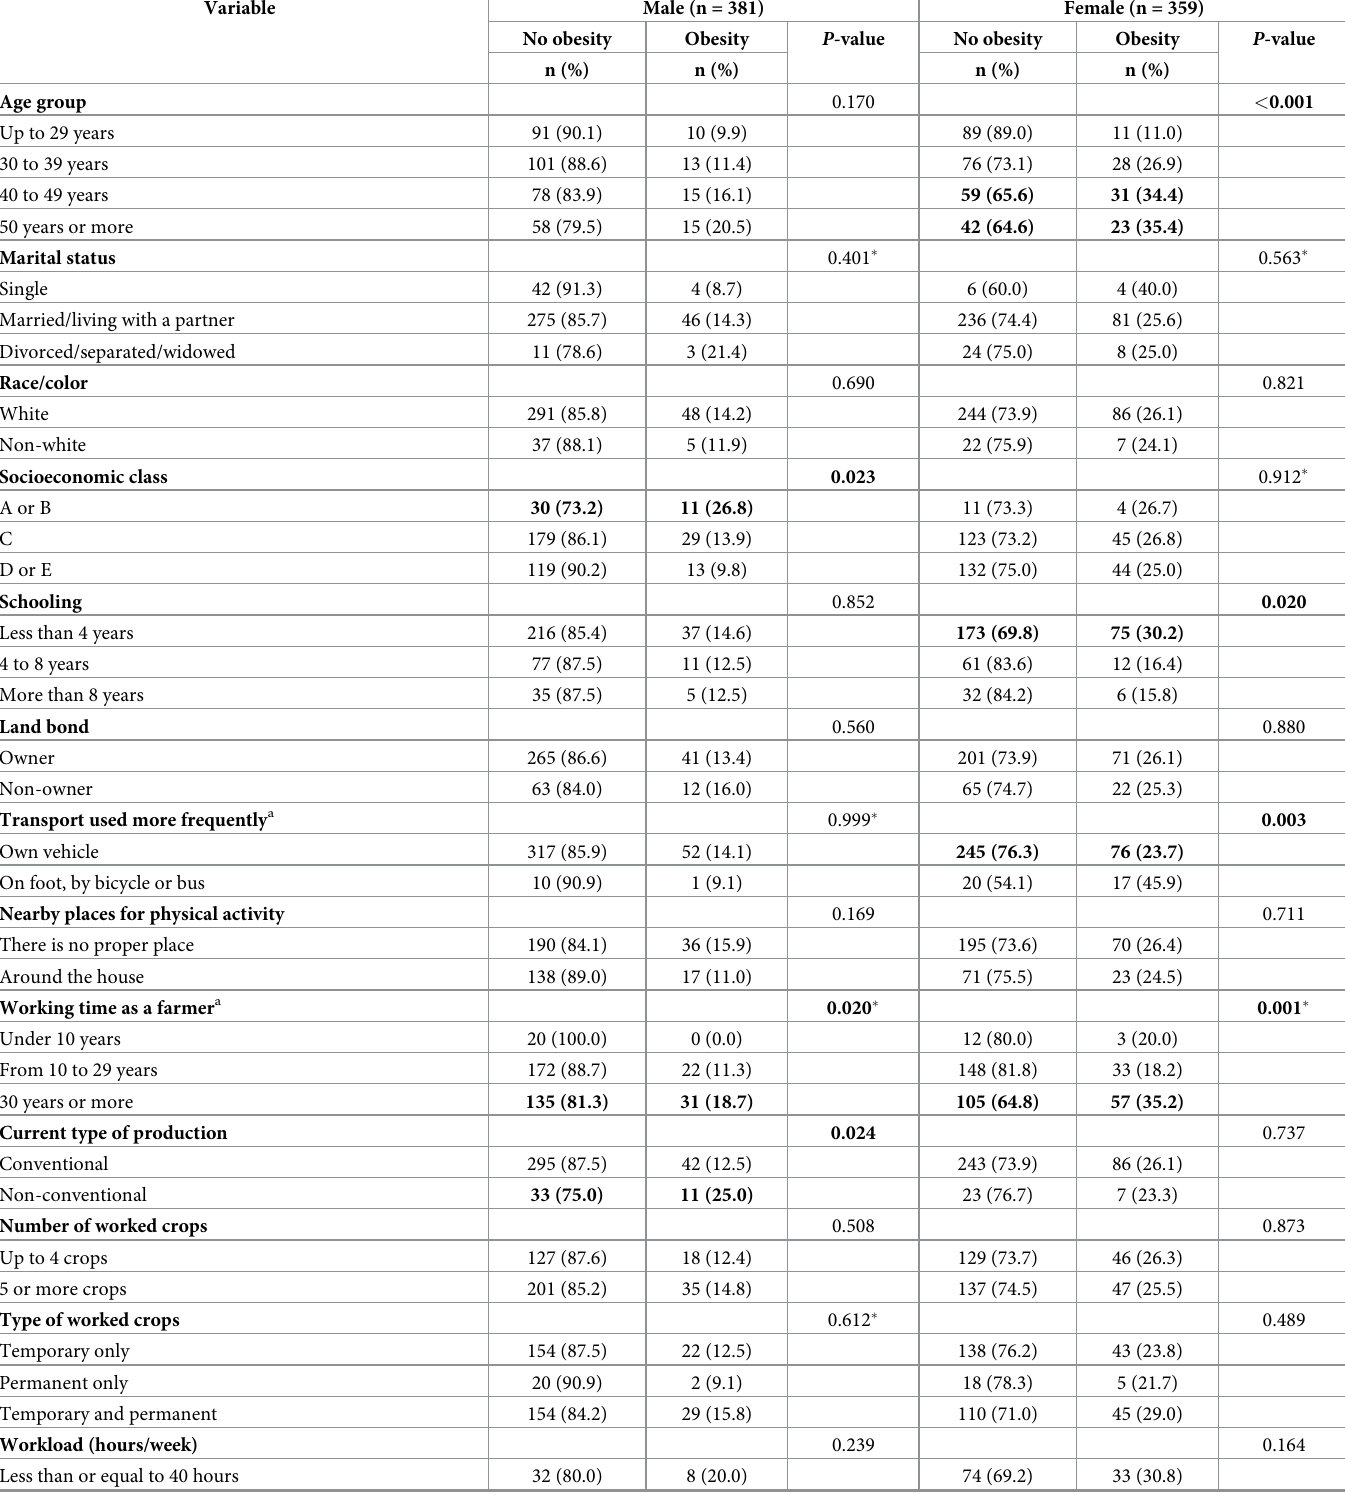
Table 3. General obesity and sociodemographic, labor, lifestyle and dietary pattern variables of a rural Brazilian population, according to